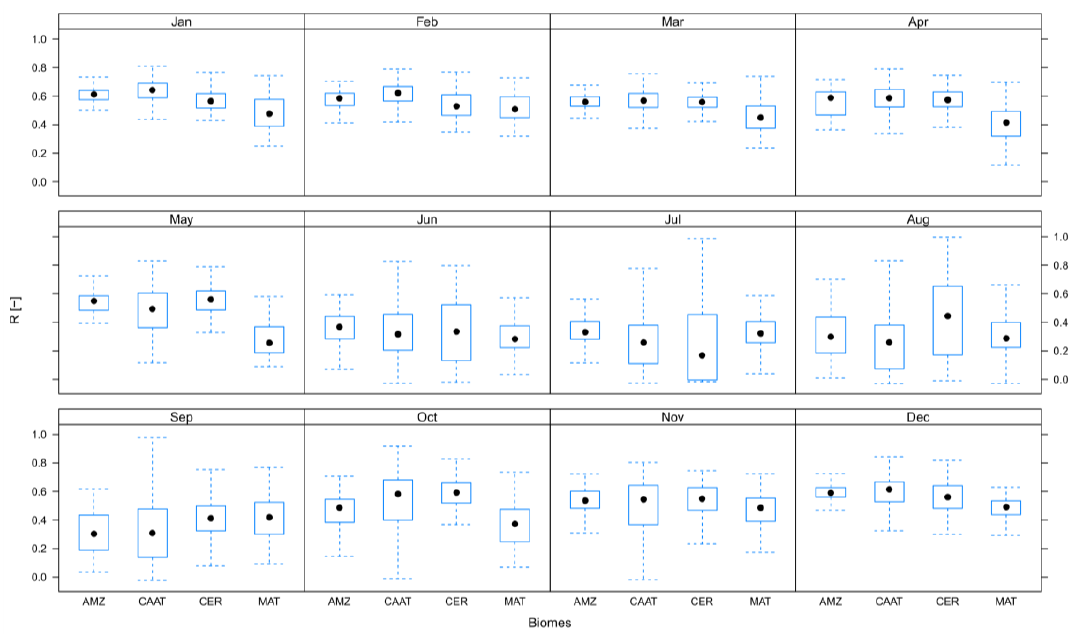
Figure 9. As per Figure 7, but for the CHIRPS rainfall product.